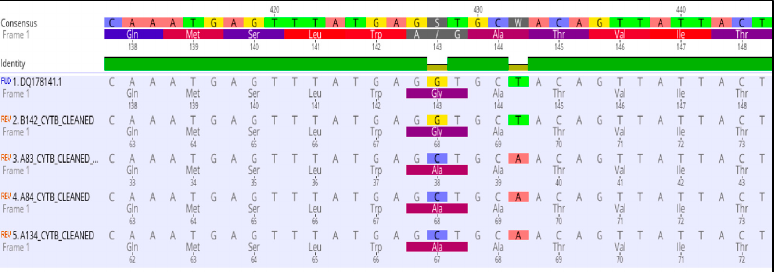
Figure 5. Multiple sequence alignment of the nucleotides and amino acids of the cytochrome b gene in the QoI resistant isolates of Aspergillus uvarum possessing the G143A mutation.